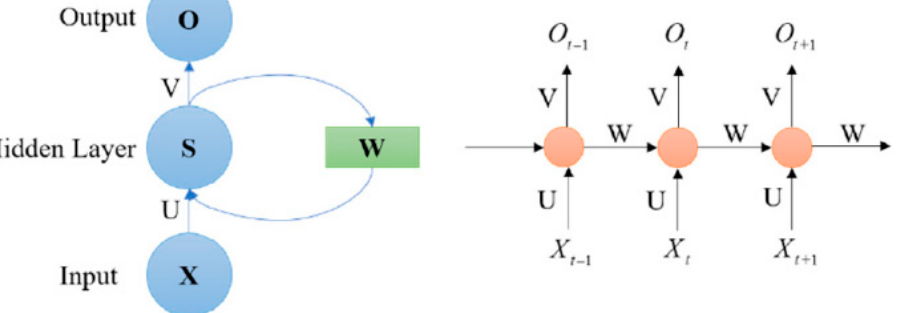
Figure 2. Framework of a Recurrent Neural Network: Input layer ( X t ); output layer ( O t ); hidden layer ( S t ); parameter matrices and vectors ( U, V, W ); activation function of output layer ( σ y ); and activation function of hidden layer ( σ h ) [65].